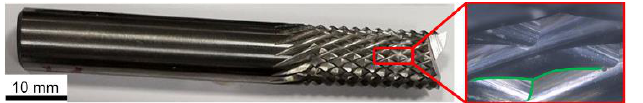
Figure 6. Illustration of a tooth of a burr tool — Periphery tooth highlighted.